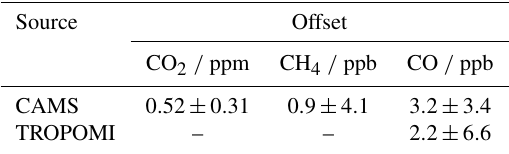
Table 4. Comparison of the EM27/SUN observations to CAMS model data and coincident TROPOMI XCO measurements. The data indicate the mean differences ± the SD of the differences for the entire